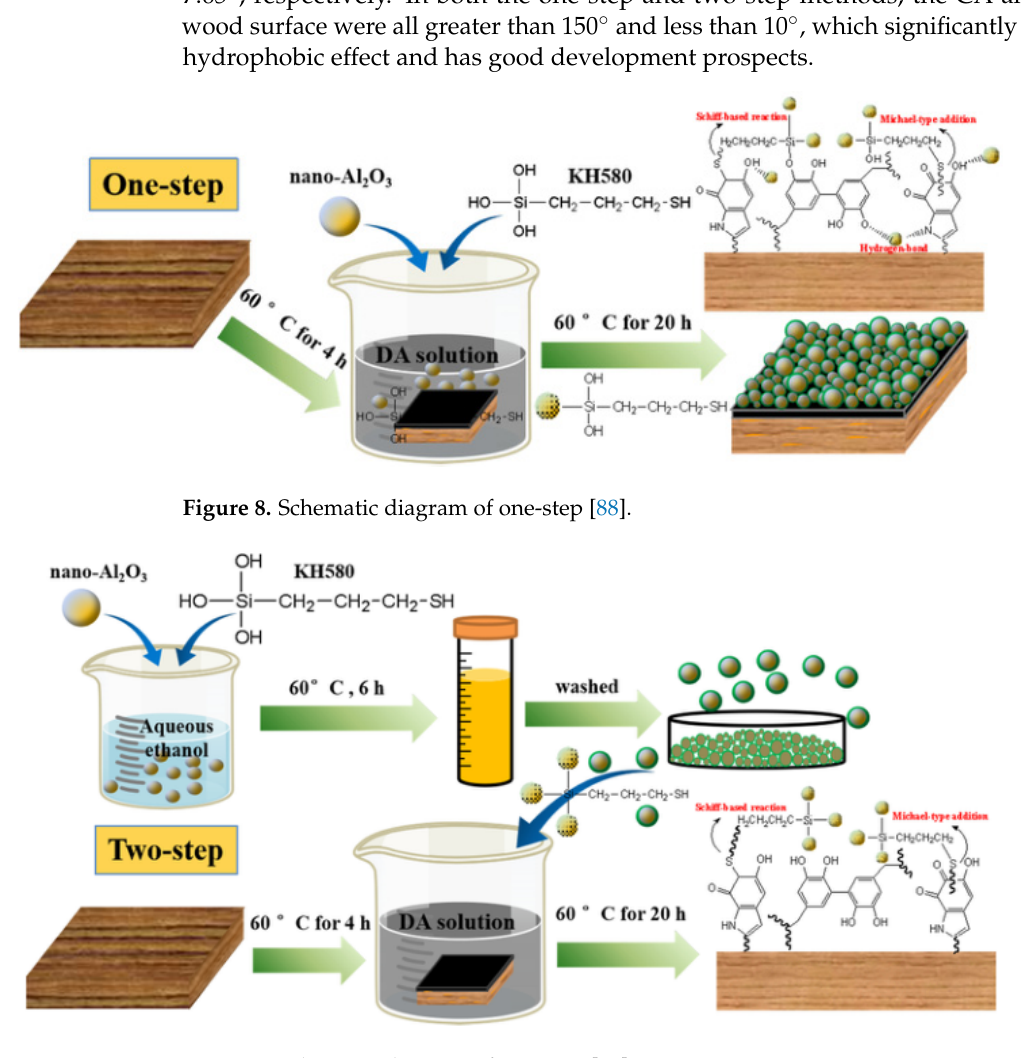
Figure 9. Schematic diagram of two-step [88].